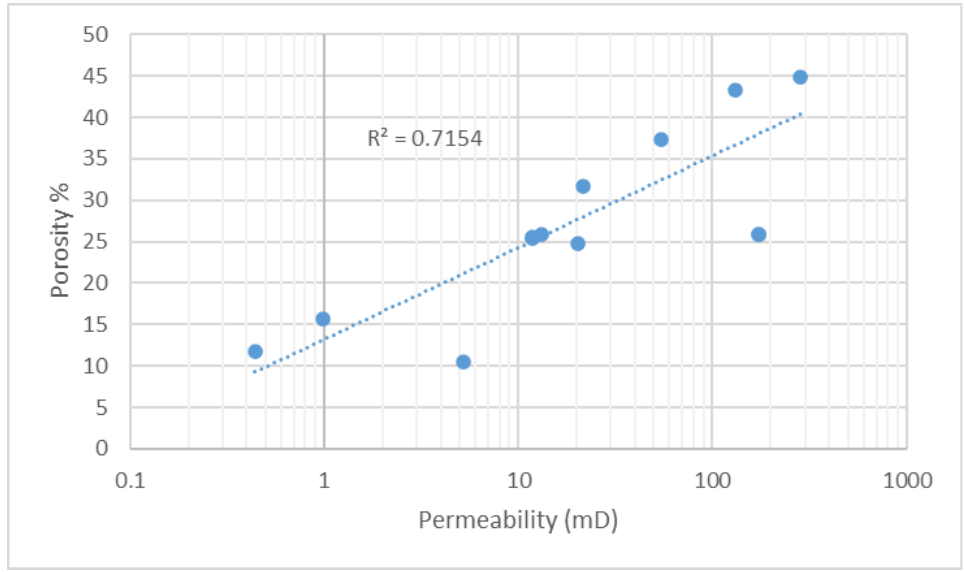
Figure 23. Scatter plot of permeability and porosity.